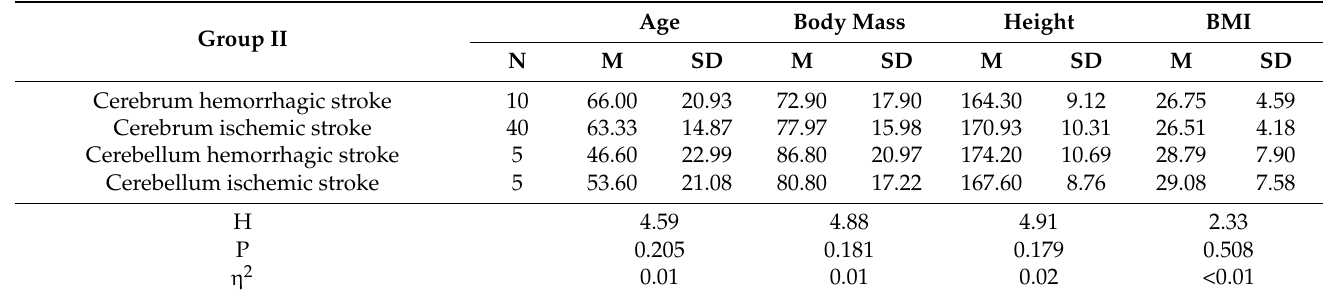
Table 2. Biometric data of the Group II—second post-stroke study population.